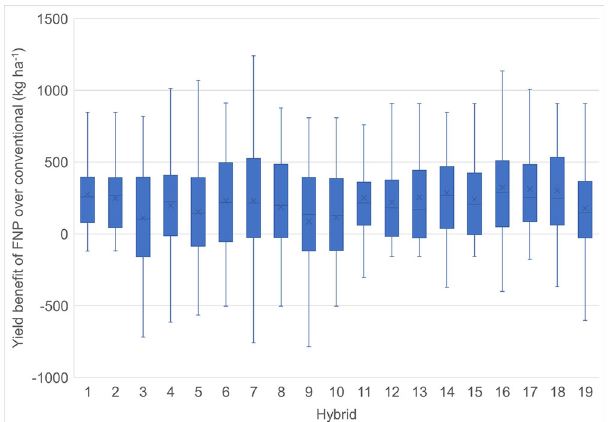
Fig. 2 Yield bene fi ts of FNP hybrids are consistent across multiple hybrids. Box and whisker plots indicate the range in yield bene fi t (kg ha − 1 ) for FNP hybrid compared with conventional control for 19 hybrids, each grown in at least 20 locations. Hybrids 1 – 11 are single crosses, 12 – 19 are three-way crosses. Seven hybrids were removed as they were grown in 12 or fewer locations. X represents the mean, the solid box represents 25th – 75th percentile and the whiskers represent the minimum and maximum of the distribution. Outliers (>1.5 outside the outer quartile) were removed. N (number of locations) are 22 (hybrids 12, 13, 15, 19), 26 (hybrids 1, 11, 14, 17), 34 (hybrids 2, 8, 9), 38 (hybrids 3, 6), 40 (hybrid 10), 48 (hybrids 16, 18), 62 (hybrid 5), 68 (hybrid 4), and 74 (hybrid